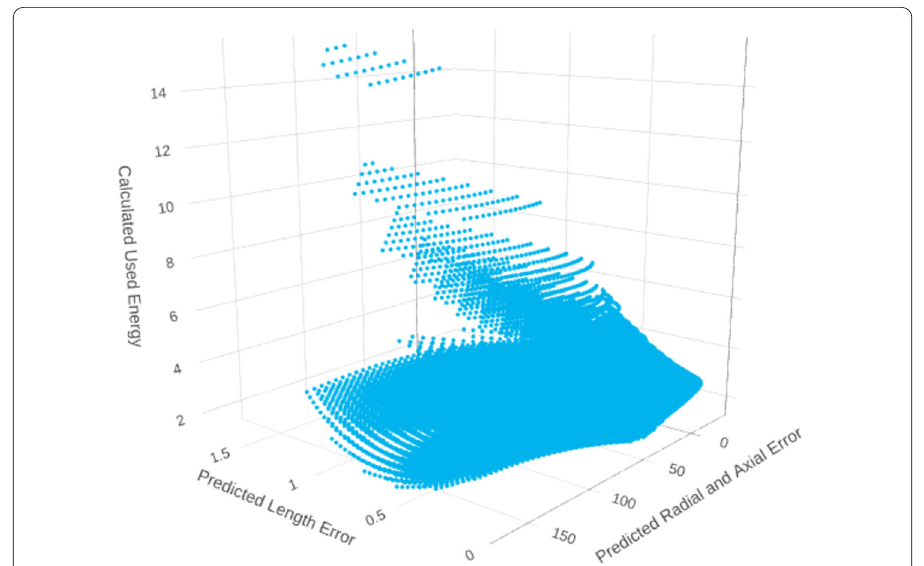
Figure 9 Case Study 1: Predictions of metamodels iteration k = 1. Note: Energy is calculated using Equation